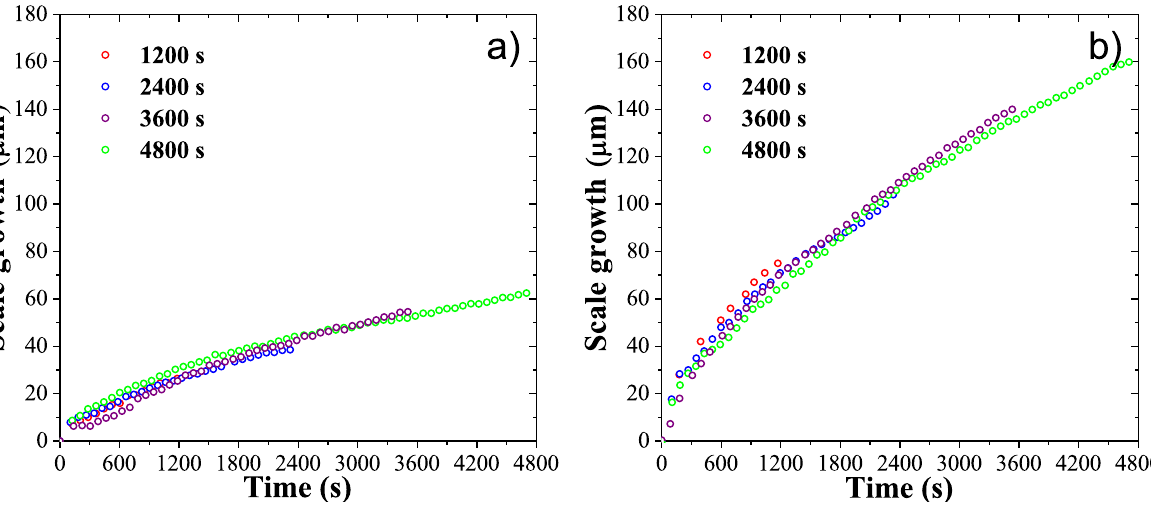
Figure 3. Oxide layer growth for reproducibility testing at: ( a ) 850 and ( b ) 1000 ◦ C, during 1200, 2400, 3600, and 4800